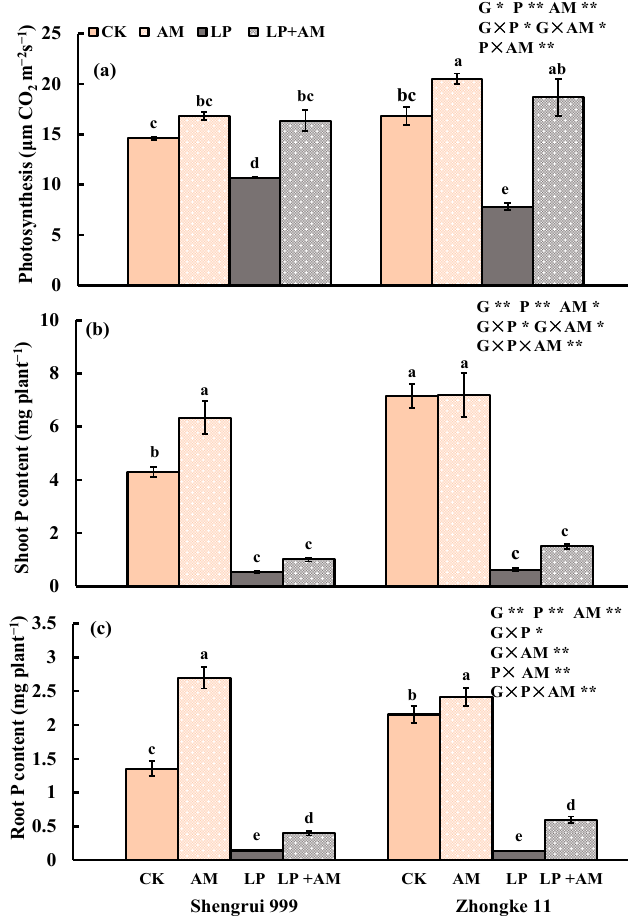
Figure 2. Photosynthesis ( μ m CO 2 m –2 s − 1 ) ( a ), shoot P content (mg plant − 1 ) ( b ), and root P content (mg plant − 1 ) ( c ) of two maize genotypes (Shengrui 999 and Zhongke 11) under four treatments (*, p ≤ 0.05; **, p ≤ 0.01).